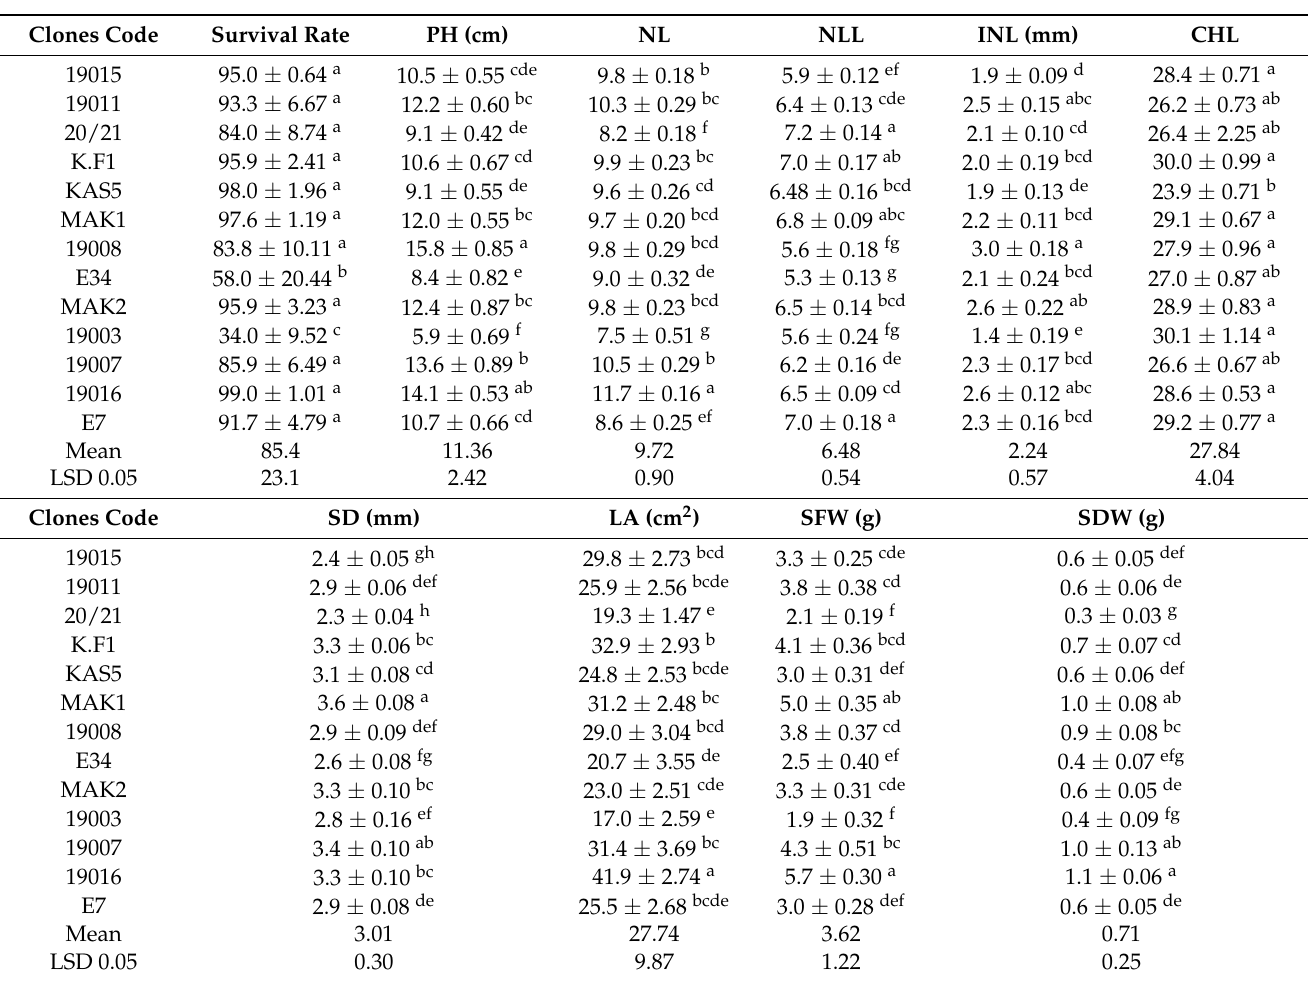
Table 1. Mean values of survival rate and shoot traits variation among 13 elite Melia volkensii Gürke clones after two months of